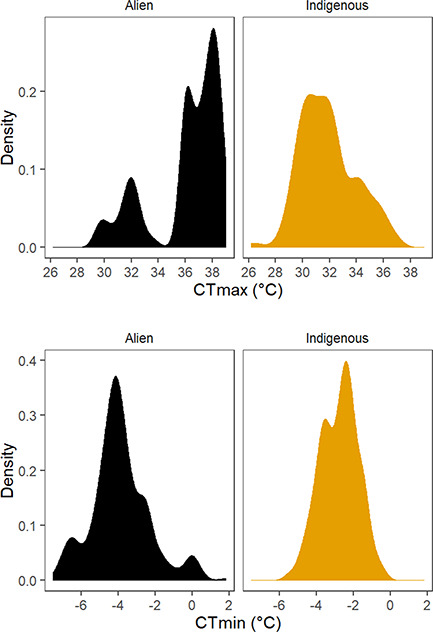
Density plots of thermal tolerance in individuals. (A) CTmax and (B) CTmin for the indigenous and alien assemblages of springtails from Macquarie Island measured in the F0 generation after 7 days at 10°C acclimation